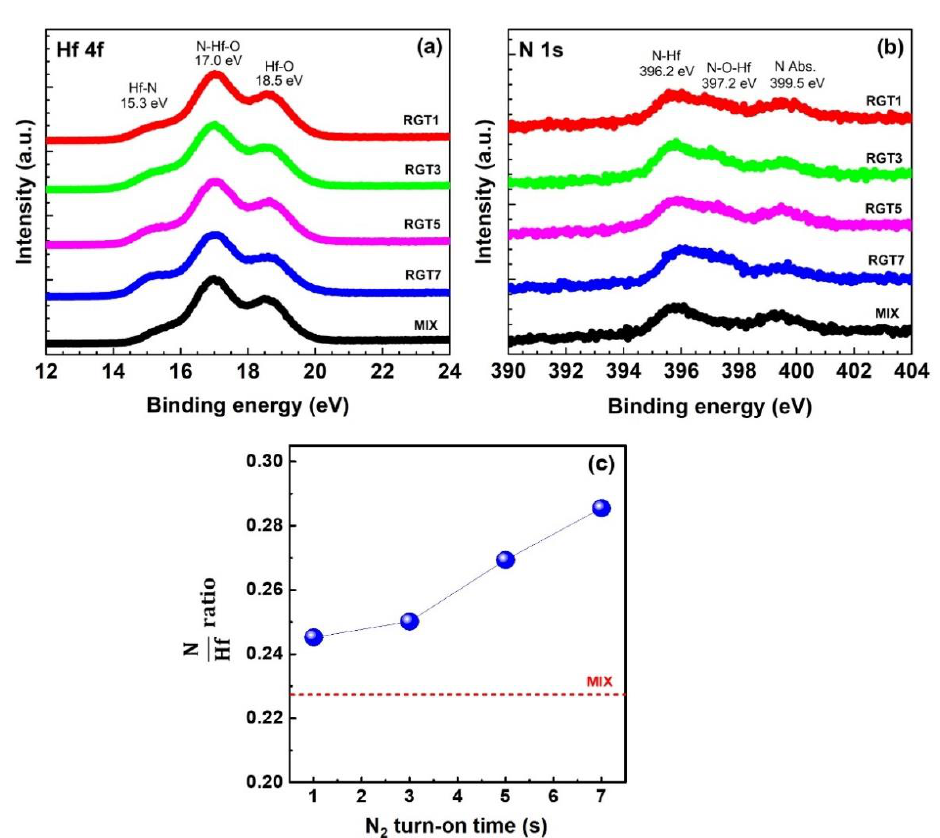
N ratio. Figure 5. XPS spectra of ( a ) Hf 4f and ( b ) N 1s. ( c ) Relationship between N 2 turn-on time and Hf Hf